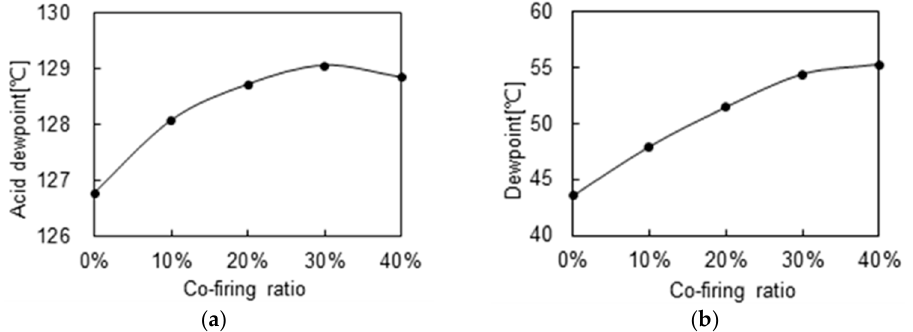
Figure 6. Effect of ammonia co-firing on ( a ) sulfuric acid dew point and ( b ) water vapor dew point.